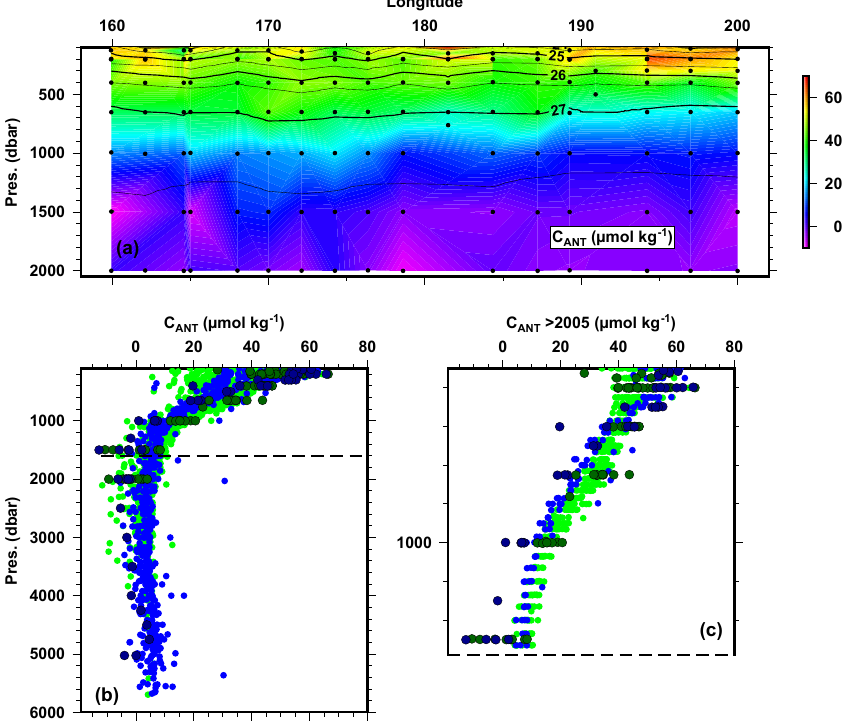
Figure 4. Longitudinal variations in C ANT (estimated with the TrOCA method) along the OUTPACE transect between 100 and 2000dbar depth (a) . Black contour lines represents the isopycnal horizons based on potential density referenced to a pressure of 0dbar. Vertical profiles of C ANT for the entire OUTPACE dataset superimposed on the values estimated from the GLODAPv2 data (b) and vertical profiles of C ANT between 100 and 1500dbar superimposed on the values estimated from the recent (after 2005) GLODAPv2 data (c) . The color code for the dots is the same as for Fig.